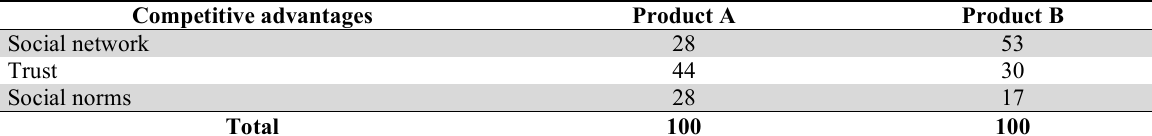
Share of competitive advantages in products “A” and “B” Competitive advantages Product A Product B Social network Social norms Total